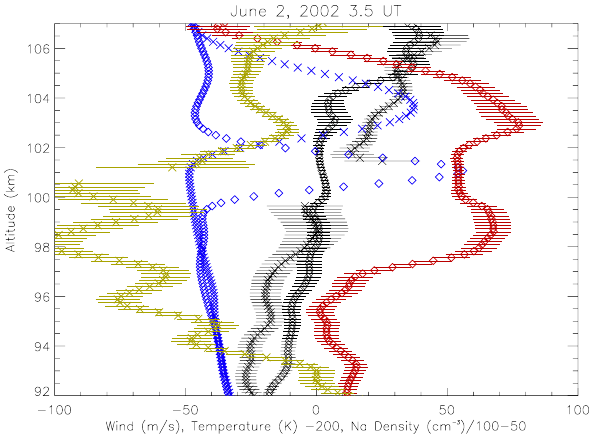
Fig. 5. Profiles of density (blue), temperature (black), and zonal (red) and meridional (green) winds with 15min and 1km resolution at 3.5 UT for beam 1 (x’s) and beam 2